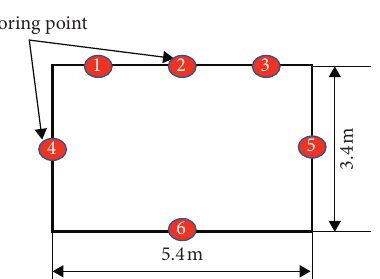
Monitoring point